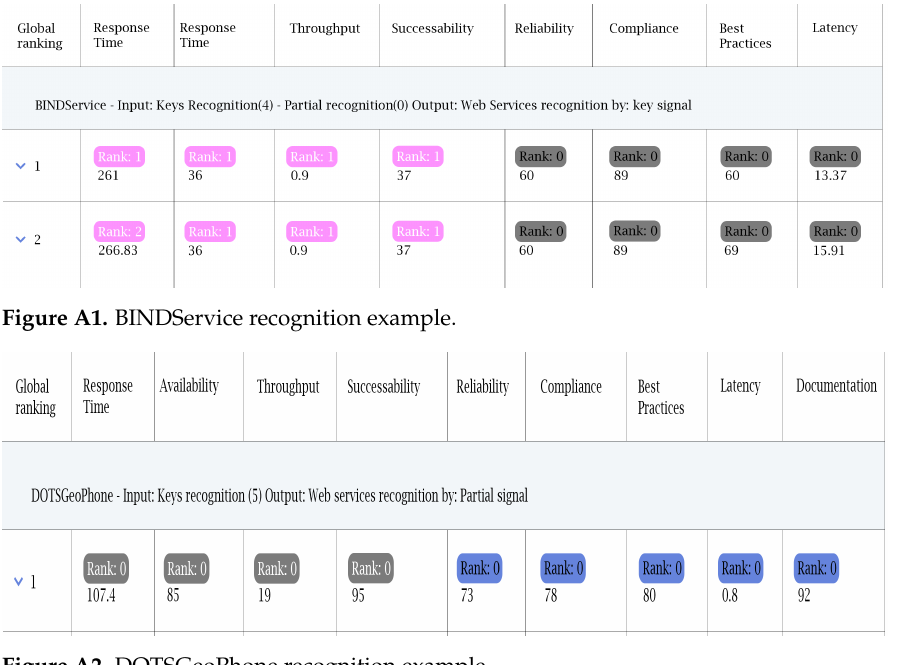
Figure A2. DOTSGeoPhone recognition